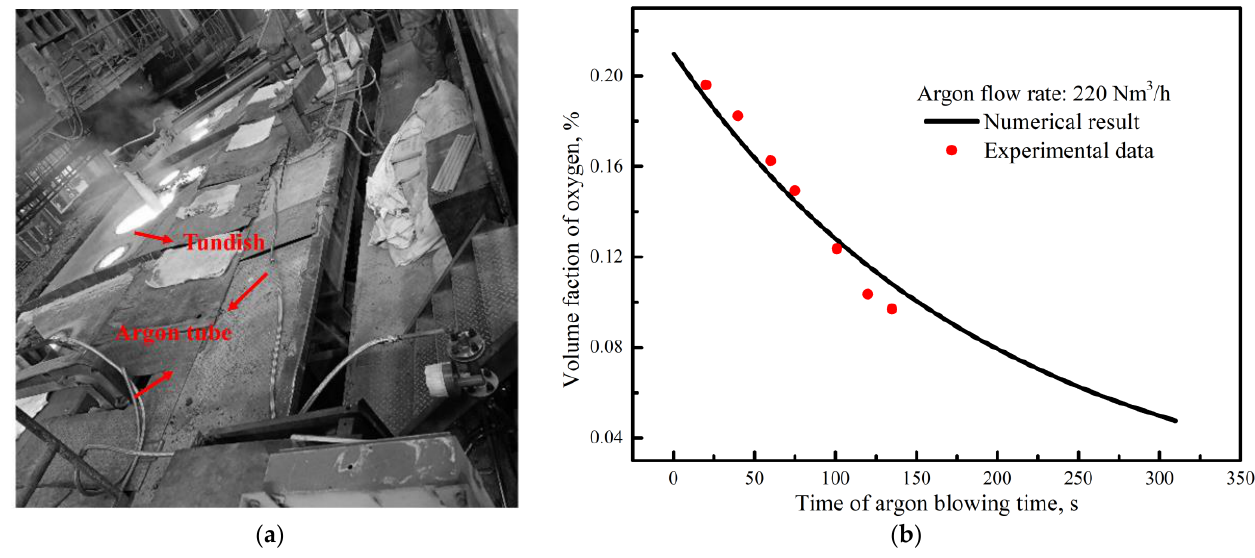
Figure 4. Snapshot of the industrial test ( a ) and comparison of the industrial test data and numerical calculation ( b ).